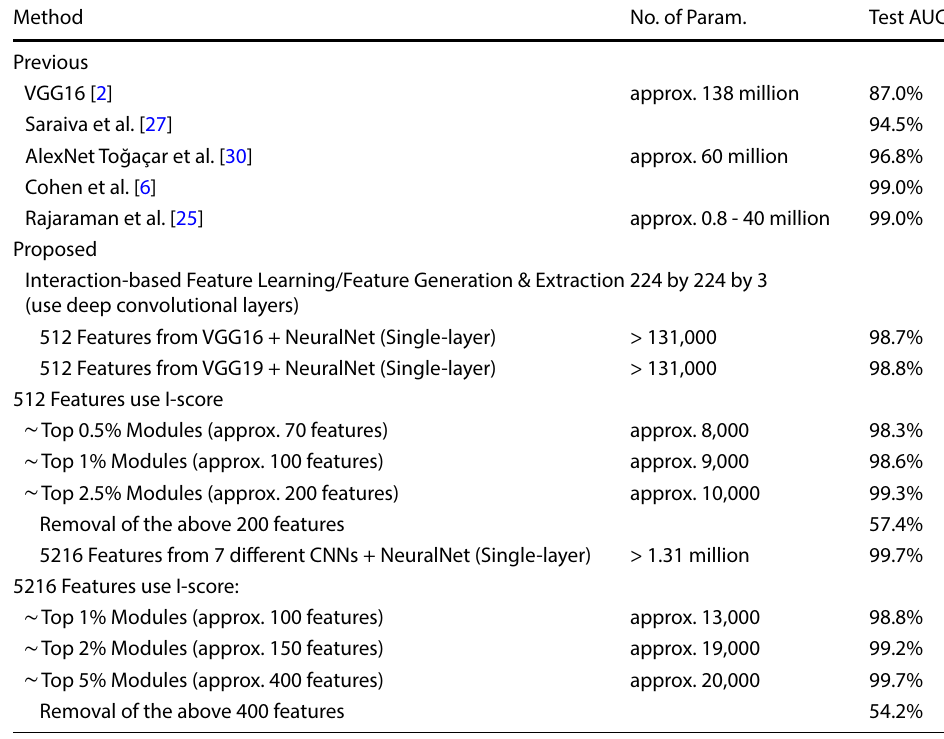
Table 3 Test set performance of the Pneumonia Chest X-ray detection data